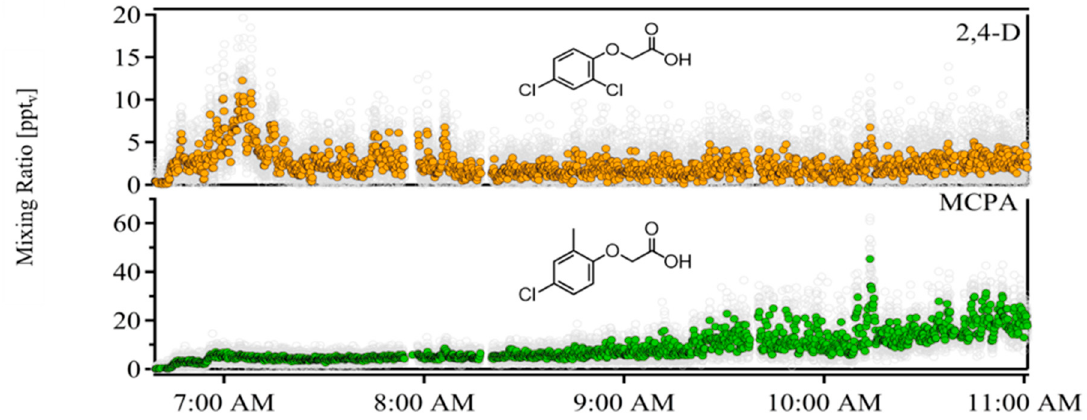
Figure 3. Time series of 2,4-D (upper panel) and MCPA (lower panel) during the entire measurement period. Ambient temperature rose from 15 ◦ C to 35 ◦ C at the conclusion of the measurement